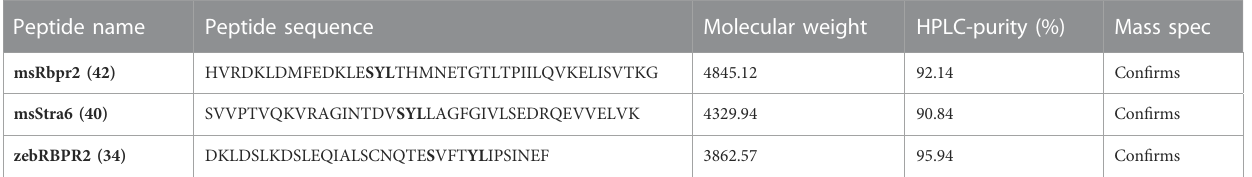
TABLE 1 Amino acid sequences of individual RBPR2 peptides used in SPR analysis. The putative mouse RBP4 “ SYL ” binding residues on RBPR2 and STRA6 are shown in bold. HPLC and Mass spectrophotometry analysis con fi rmed purity and sizes of individual